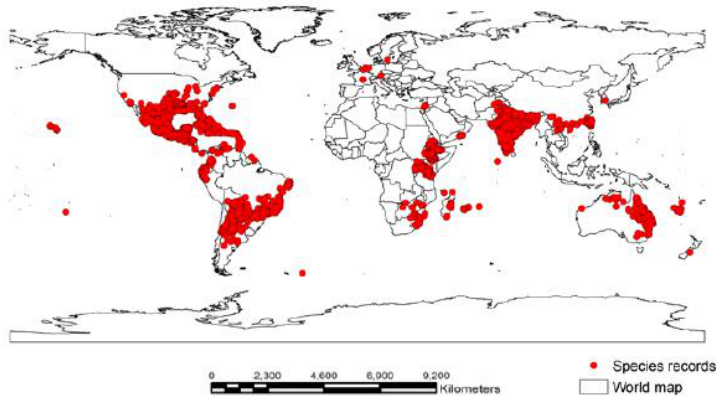
Figure 1. Global occurrence of P . hysterophorus ( n = 9234 points). The red dots shown in the figure indicate global positioning points of P . hysterophorus.